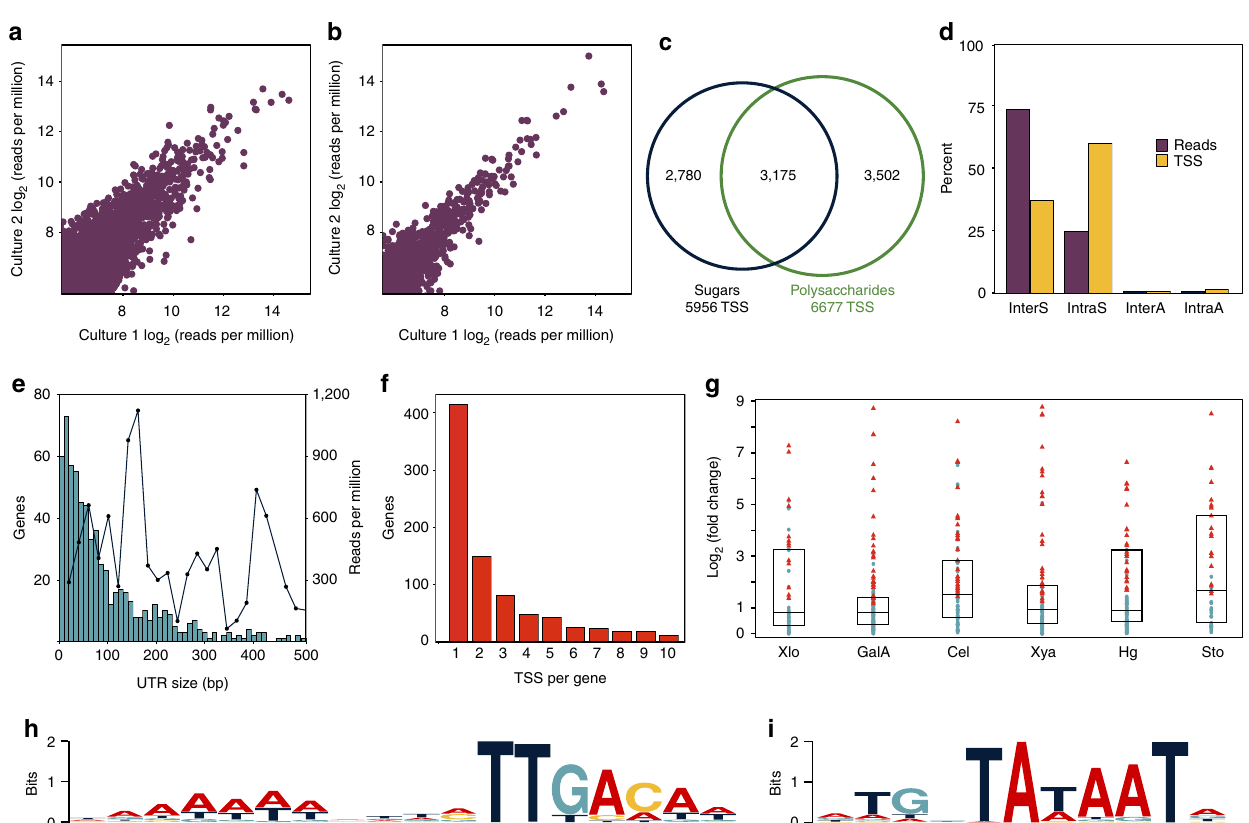
Figure 2 | General features of TSS identification by Capp-Switch sequencing. Capp-Switch reproducibly quantifies TSS usage in duplicate ( a ) glucose (4,399 TSS; R 2 ¼ 0.96) and ( b ) stover (1,532 TSS; R 2 ¼ 0.99) cultures. ( c ) Venn diagram showing overlap of TSS identified in at least one monosaccharide and one polysaccharide or biomass treatment. ( d ) Percentage of reads (purple) and TSS (yellow) classified as InterS, IntraS, InterA or IntraA summed across treatments. ( e ) The length of most 5 0 UTR (primary TSS to start codon) is o 100bp (blue bars with left Y axis), but UTR length does not correlate with expression strength (black line with right Y axis). TSS strength is the average reads per million for all TSS in a 20bp 5 0 UTR size interval. Results show glucose data. ( f ) Distribution of the number of InterS TSS per gene for data summed across treatments. ( g ) Genes with substrate-specific TSS are often differentially expressed. The Y axis is the absolute value of log 2 (RPKM substrate/RPKM glucose) from RNA-seq for all genes with InterS TSS specific to that substrate. Substrates are xylose (Xlo n ¼ 50 genes), galacturonic acid (GalA n ¼ 146 genes), cellulose (Cel n ¼ 94 genes), xylan (Xya n ¼ 91 genes), pectin (Hg n ¼ 119 genes) and stover (Sto n ¼ 48 genes). Symbols: red triangles are differentially expressed genes, blue circles unchanged genes, box shows median and interquartile range. Promoter regions upstream of TSS expressed on three sugars and polysaccharides show consensus ( h ) (cid:2) 35 and ( i ) (cid:2) 10 motifs recognized by RNA polymerase.